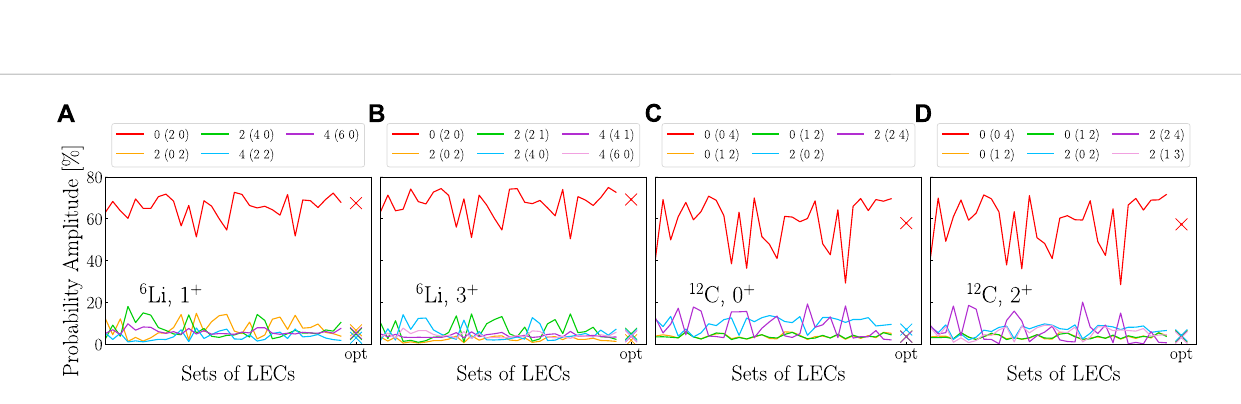
N max =6 3 [allSU(3)stateshave{ 1 statein opt parameterization in the